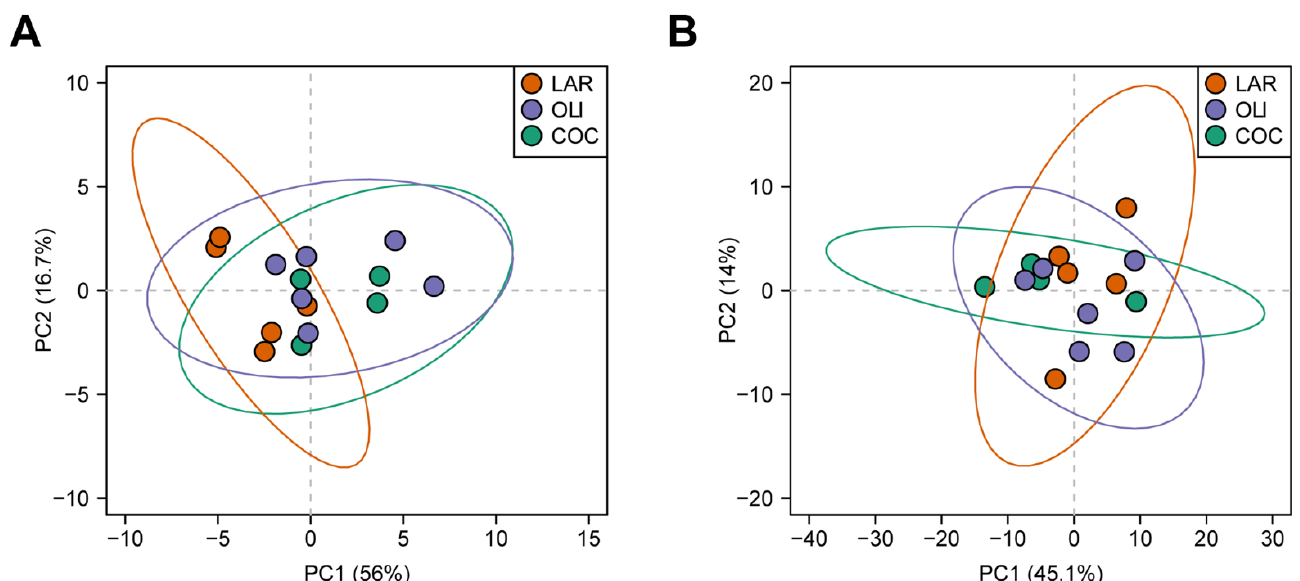
Figure 3. Principal component analysis of bile acids ( A ) and metabolites ( B ) in the frontal cortexes of juvenile Iberian pigs. Data were scaled to unit variance prior to PCA assessment. Two-dimensional visualizations of PCA scores are projected from their group centroids along components 1 and 2. p -, R-squared, and F-statistic values are derived from ANOVA assessed on the first principal component. Each point represents an individual pig; the color of the point denotes the diet.